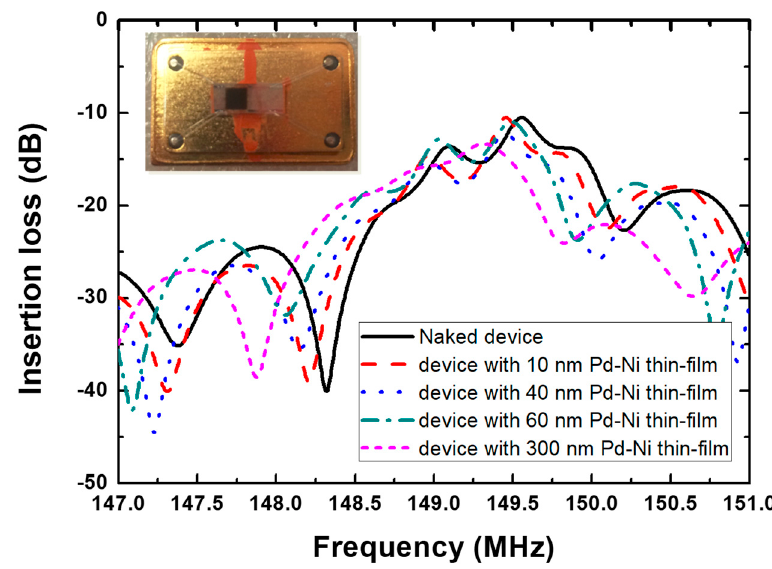
Figure 1. Measured frequency responses of the proposed sensing device depending on the Pd-Ni thin-film thickness, inset: picture of the prepared sensing device.